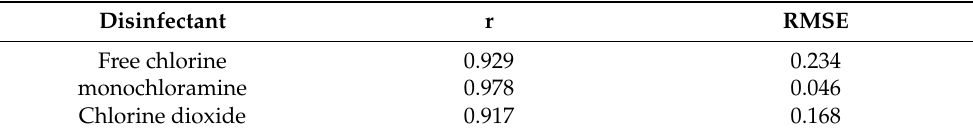
Figure 7. Predictive and measured values of ( a ) NaClO, ( b ) NH 2 CL or ( c ) ClO 2 disinfection model. The prediction performance of the models was expressed with correlation coefficient and Root Mean Square Error (RMSE). Table 2 illustrates the correlation coefficient (r) and RMSE of the three disinfection models. Table 2. Correlation coefficient and RMSE of two disinfection models.